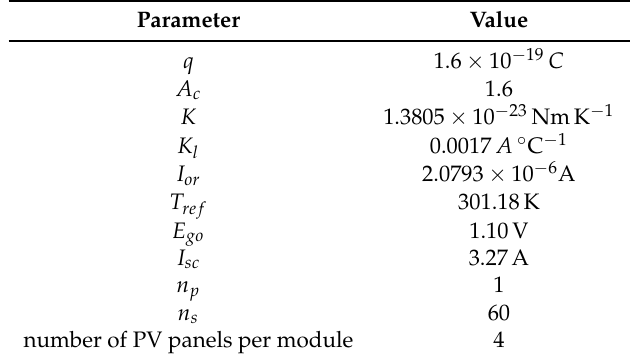
Table 3. Parameters of each PV panel (250W p